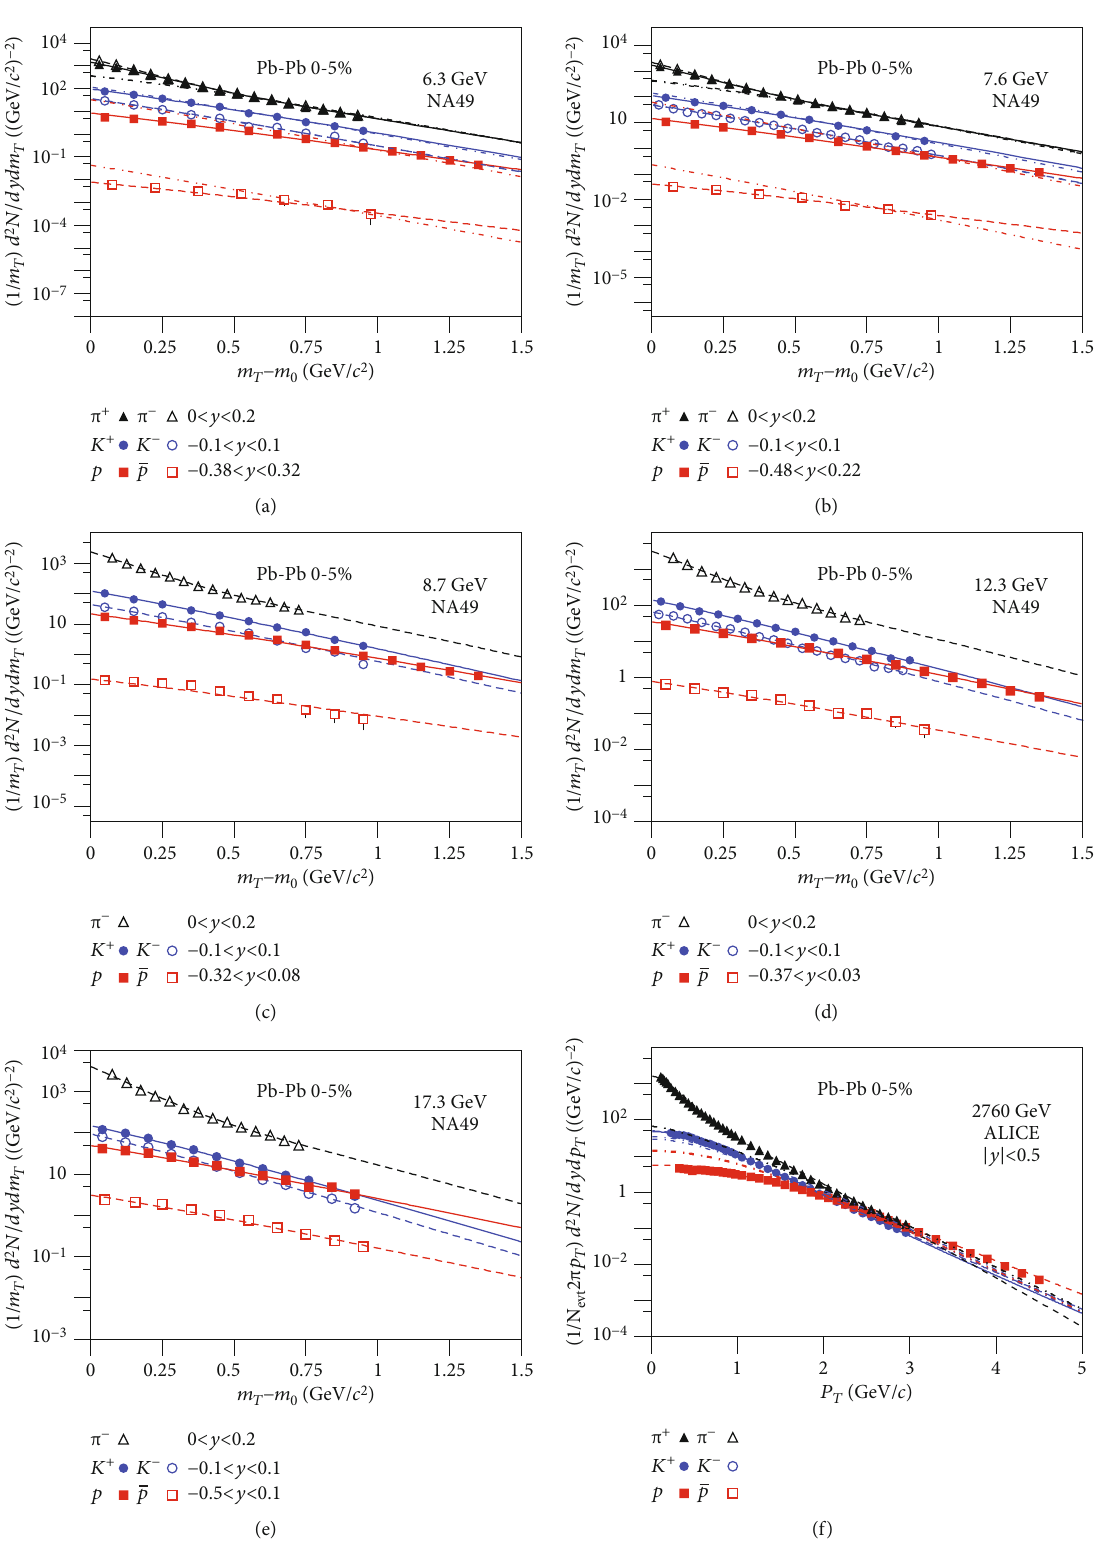
Figure 2: Same as in Figure 1 but showing the spectra of various particles produced at mid- y in central Pb-Pb collisions at high the factor ð 1/2 π Þ on the vertical axis is removed in some cases and N evt if available denotes the particle number which can be removed. The symbols represent the experimental data measured by (a – e) the NA49 [35 – 37] and (f) the ALICE [38]